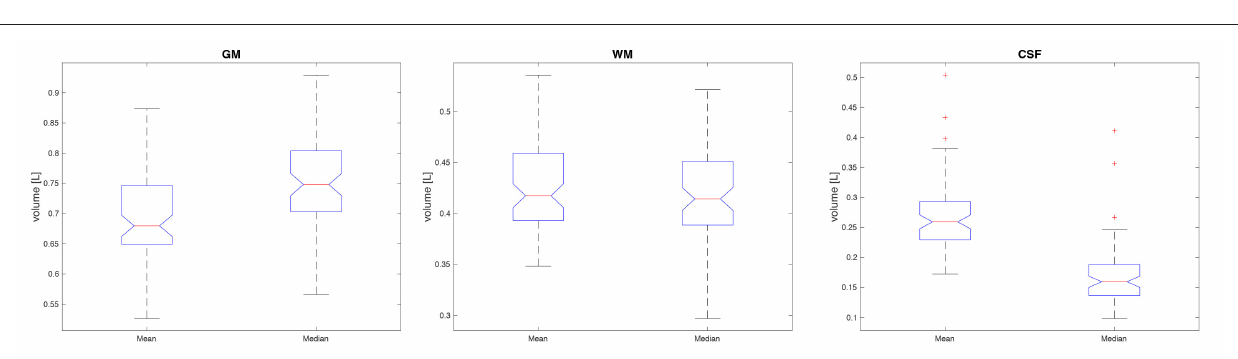
FIGURE 10 | The boxplots of the volumes obtained with the parametric (mean) and non-parametric (median) TPM in the segmentation algorithm. The GM volumes are shown on the (left) , the WM values in the (middle) , and those for CSF on the (right)